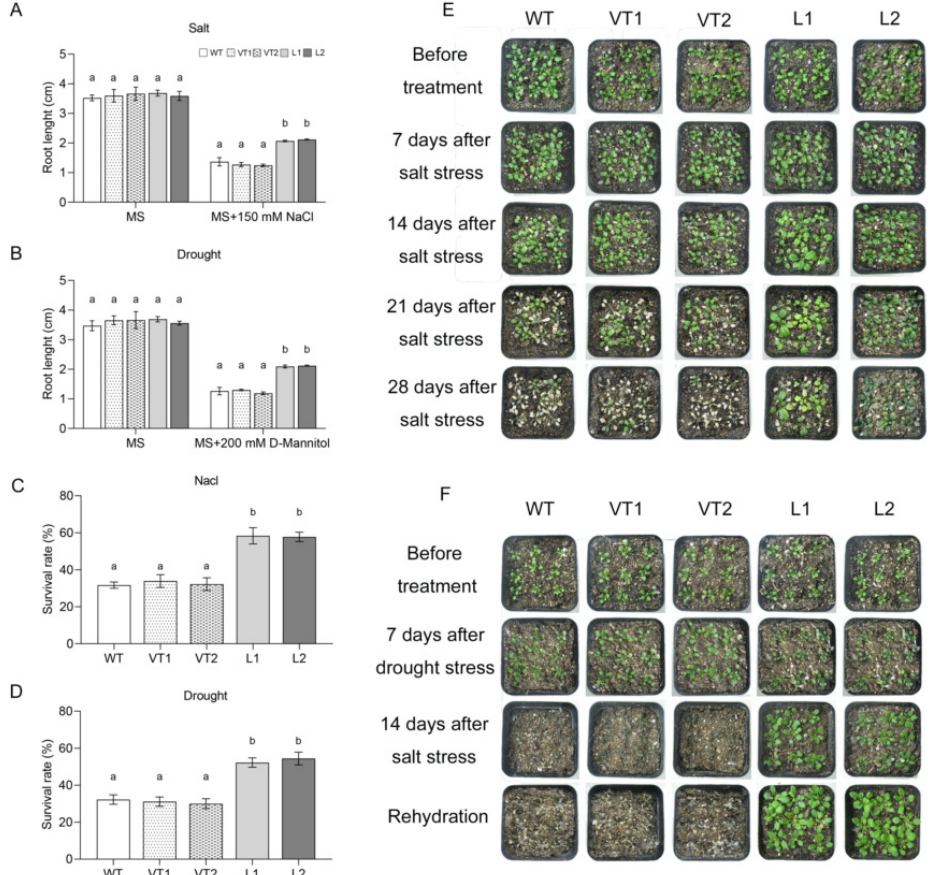
Figure 5. The root lengths and survival rates of Arabidopsis under drought and salt stress. The primary root length of wild and transgenic Arabidopsis cultured in ( A ) MS and MS + 150 mM NaCl; ( B ) MS and MS + 200 mM D-mannitol. The survival rates of wild and transgenic Arabidopsis under ( C ) MS + 150 mM NaCl; ( D ) MS+200 mM D-mannitol. Phenotypes of each line of Arabidopsis at different times of ( E ) salt treatment; ( F ) drought treatment. The data were means ± SD from three independent replications. Different lowercase letters indicate significant differences between different columns under the same treatment conditions ( p < 0.05).